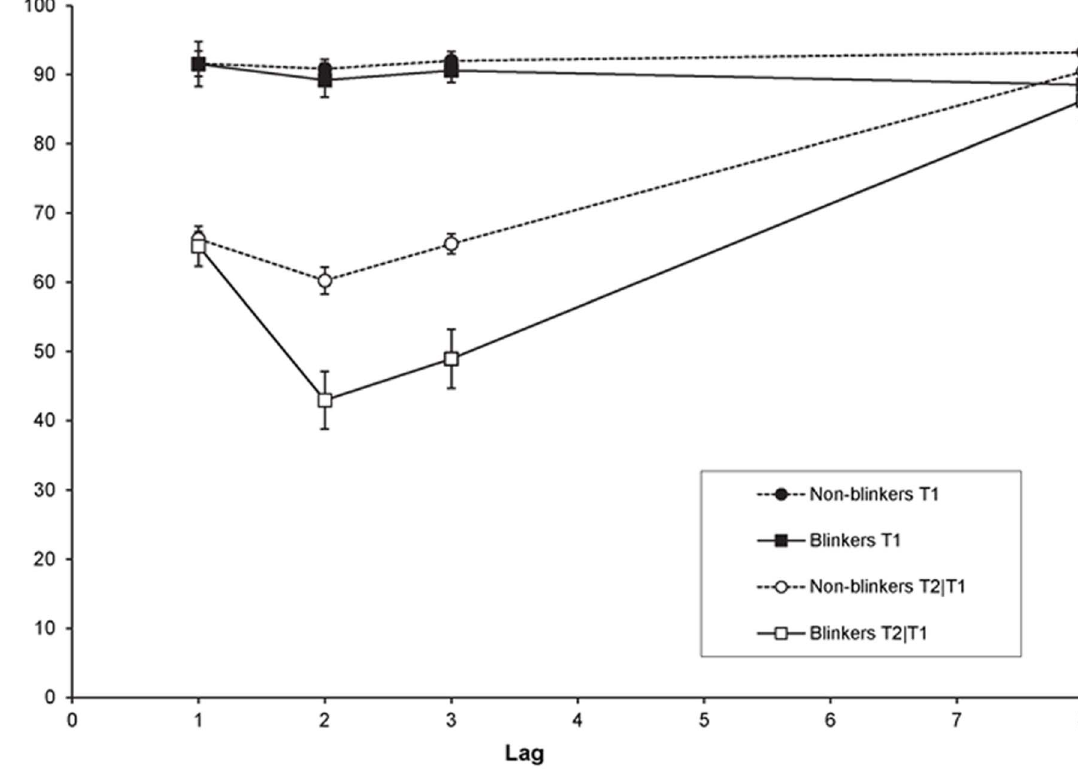
Figure 2. Target accuracy in Experiment 1b. Mean percentage correct report of T1 and T2 given correct report of T1 as a function of lag, for non-blinkers and blinkers. Error bars reflect standard error of the mean. doi:10.1371/journal.pone.0066185.g002 PLOS ONE |